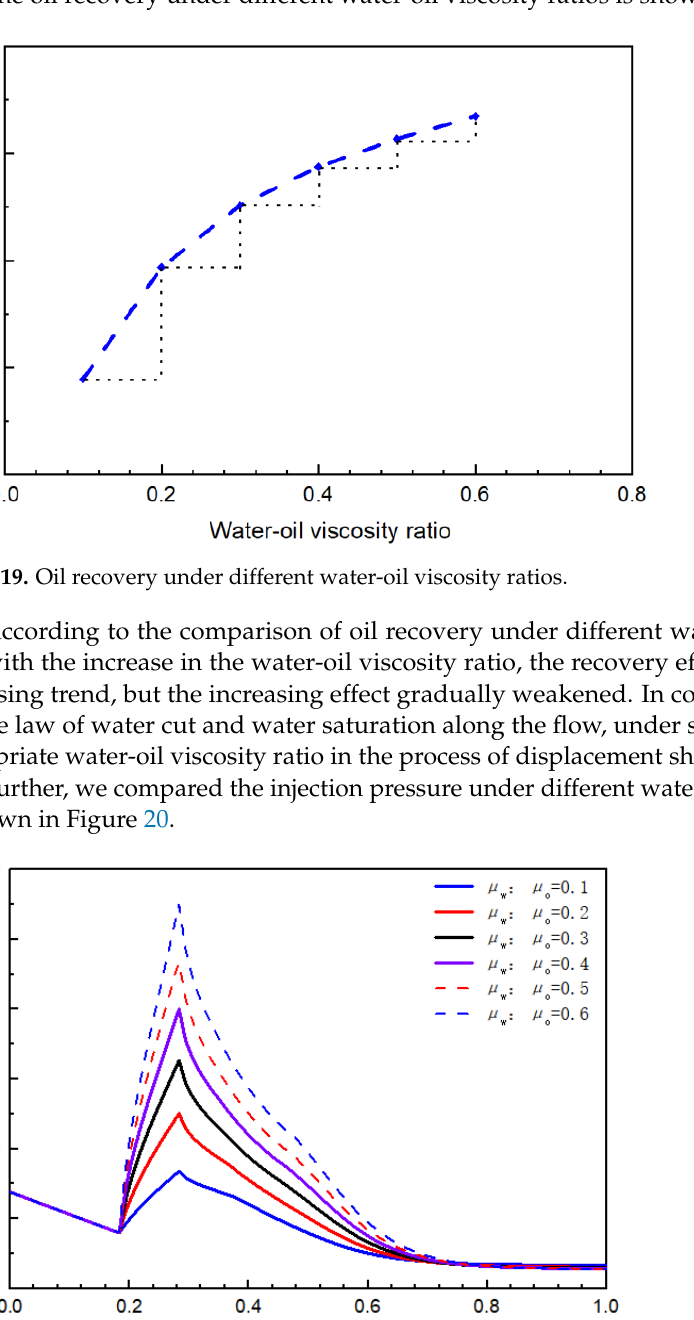
Figure 18. The change curves of the water cut under different viscosity conditions.